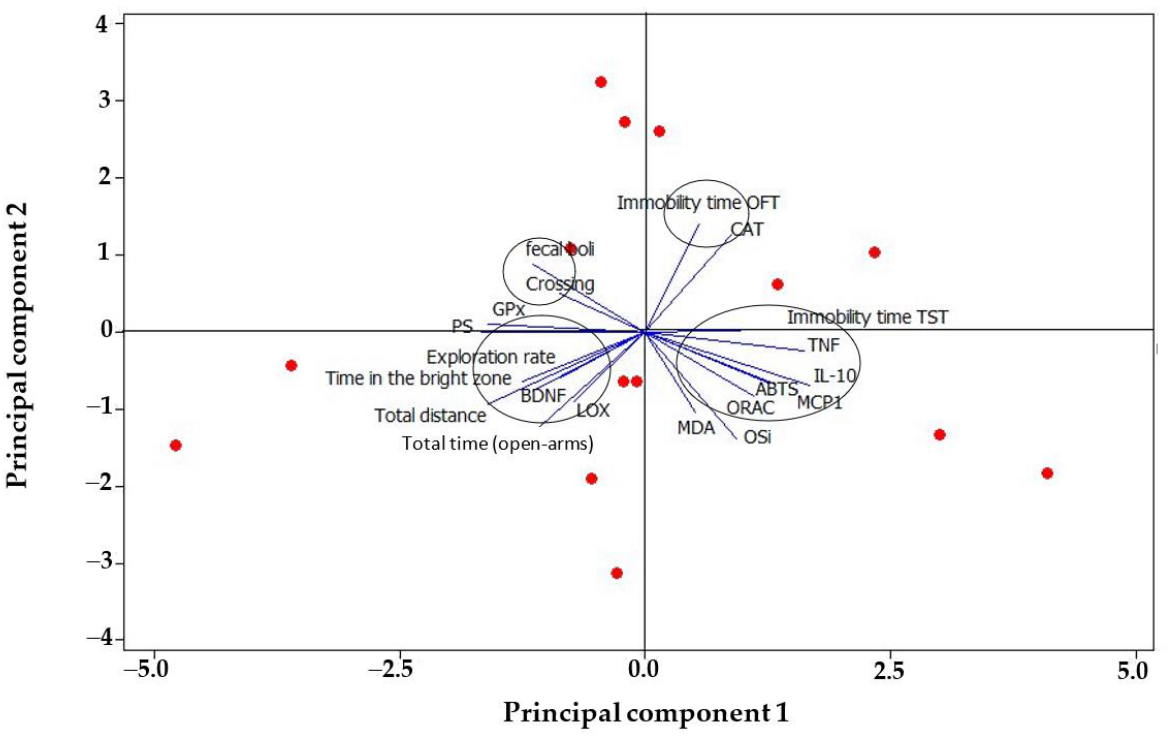
Figure 5. Analysis of principal components grouping biochemical variables and behavioural varia- bles of depression and anxiety. CAT: catalase, OFT: Open Field Test, TST: Tail Suspension Test, BDNF: Brain-derived Neurotrophic Factor, OSi: Oxidative stress index, LOX: Lipoxygenase, PS: Preference Sucrose, GPx: glutathione reductase.